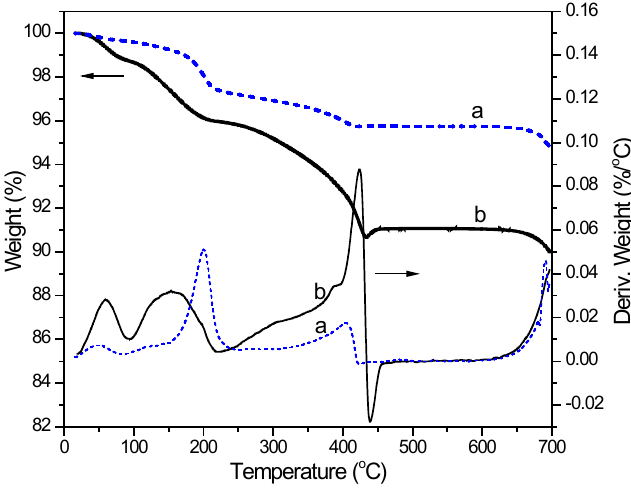
Figure 1. TGA (Thermo-Gravimetric Analysis) and DTG (Derivative Thermo-Gravimetry) curves of the fresh samples (precursors) heated in air (a: APMV/CPM and b: bulk